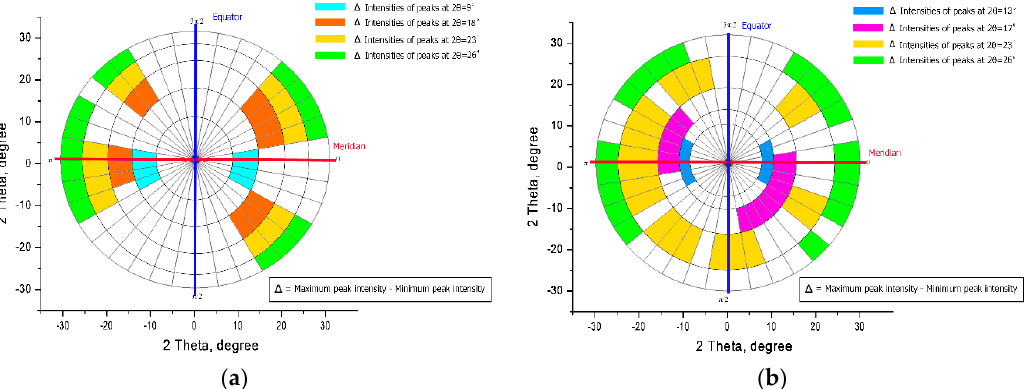
Figure 3. Diagram showing peak azimuthal intensities in the polar coordinate system (2 θ , ϕ ): ( a ) after irradiation and ( b ) after 3